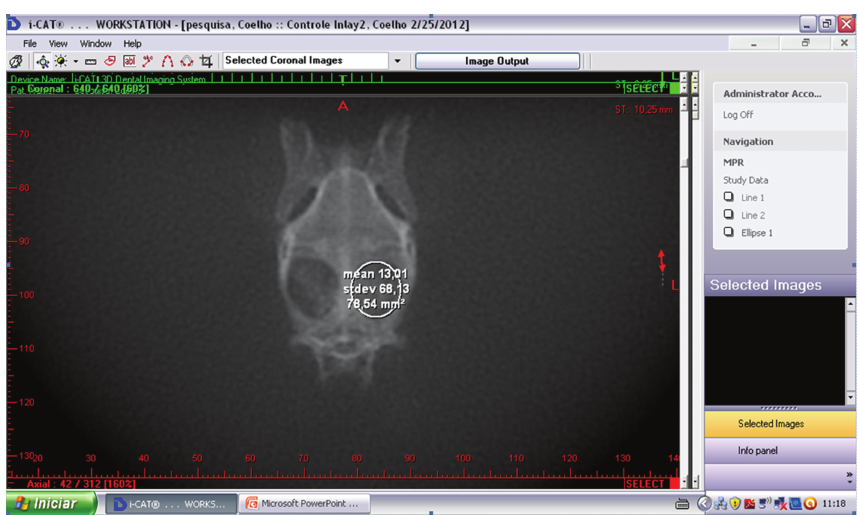
Figure 6: CT view after the measurement of a residual defect area.